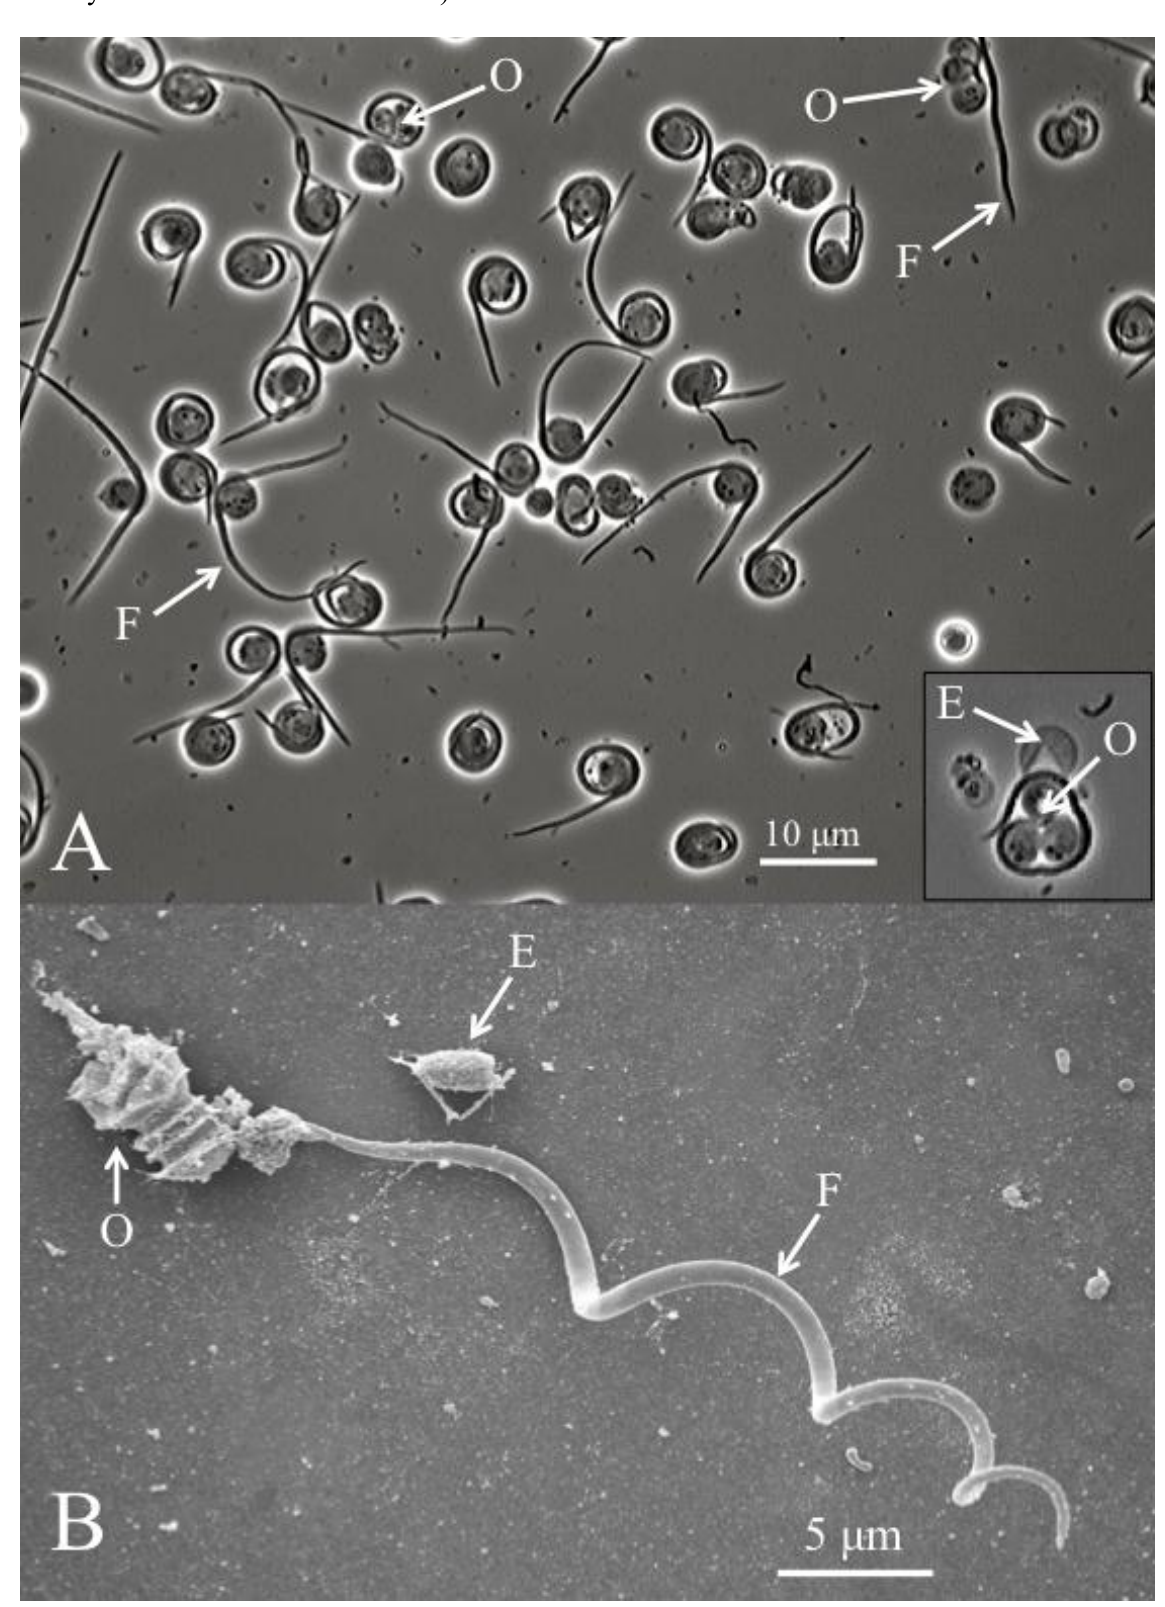
Figure 2. ( A ) Helicosporidium cyst dehiscence observed under light microscopy, showing groups of three ovoid cells (O), diagnostic filamentous cells (F) and empty pellicles (E). ( B ) Scanning electron micrograph detailing the filamentous cell and its barbs (pointing away from the core of ovoid